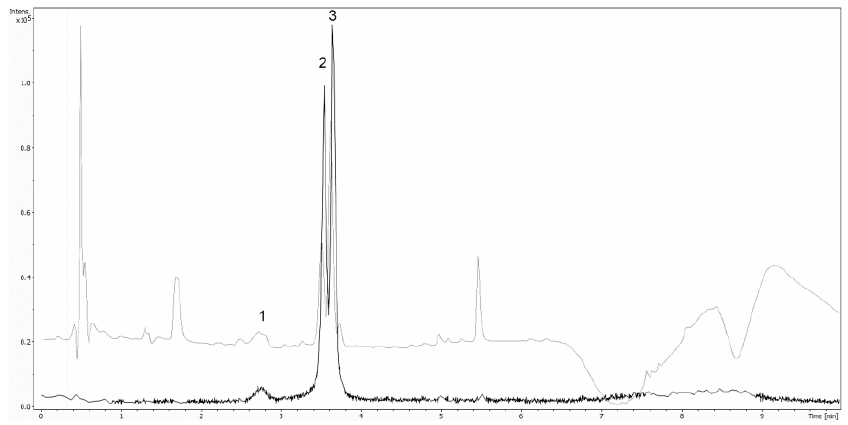
Figure 1. Overlay of extracted ion chromatograms of Cy-3-sam-5-glu (m / z 743.23) (1), Cy-3-glu (m / z 449.12) (2) and Cy-3-sam (m / z 518.17) as well as UV 279 nm .